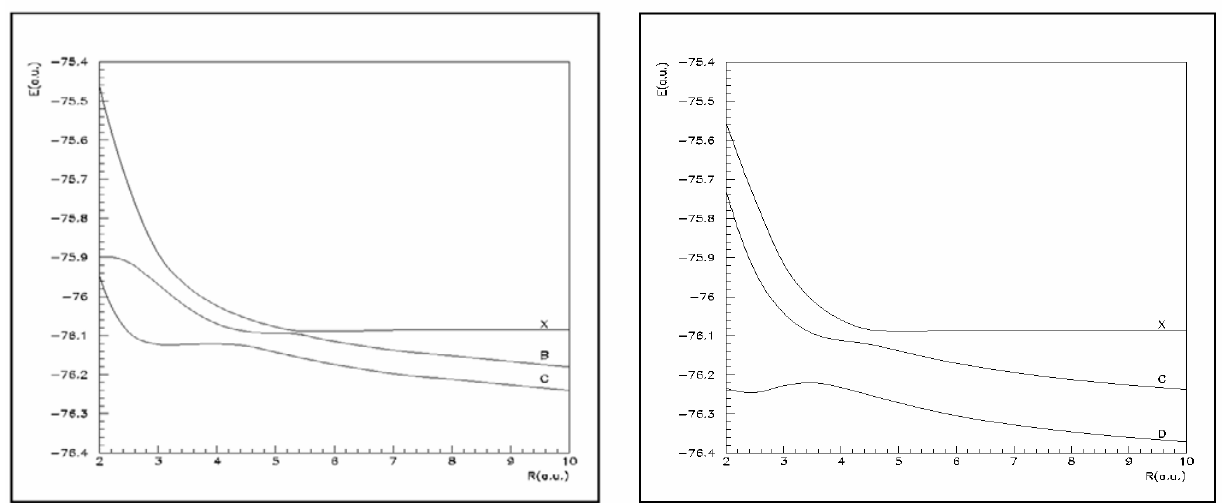
Fig. 3a,b : Adiabatic potential energy curves for respectively the 3 Σ - and 3 Π states of O 2+ + He [40]. (labels defined in the